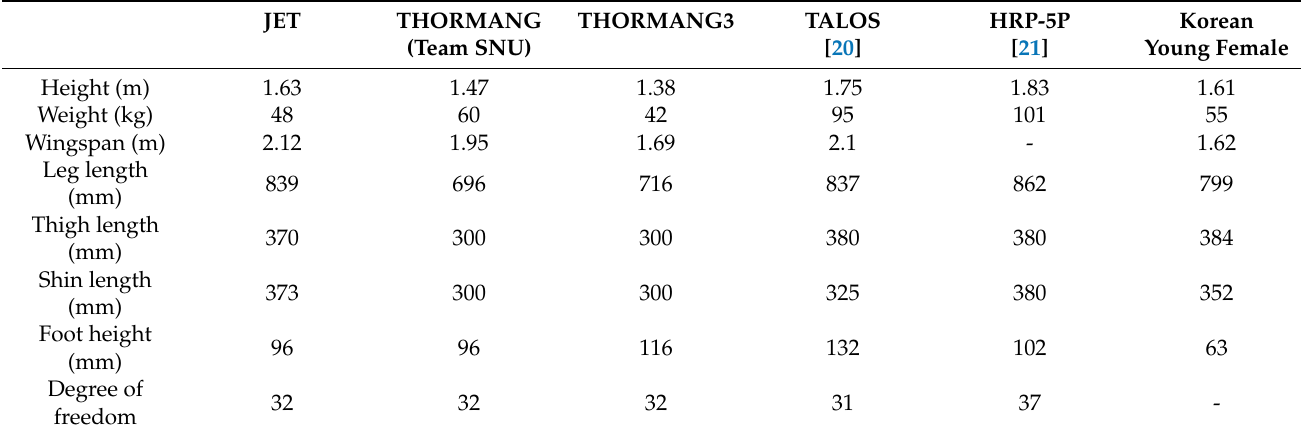
Table 2. Comparison of JET, THORMANG (Team SNU), THORMANG3, TALOS, HRP-5P, and average Korean young female (aged 20–24) characteristics.